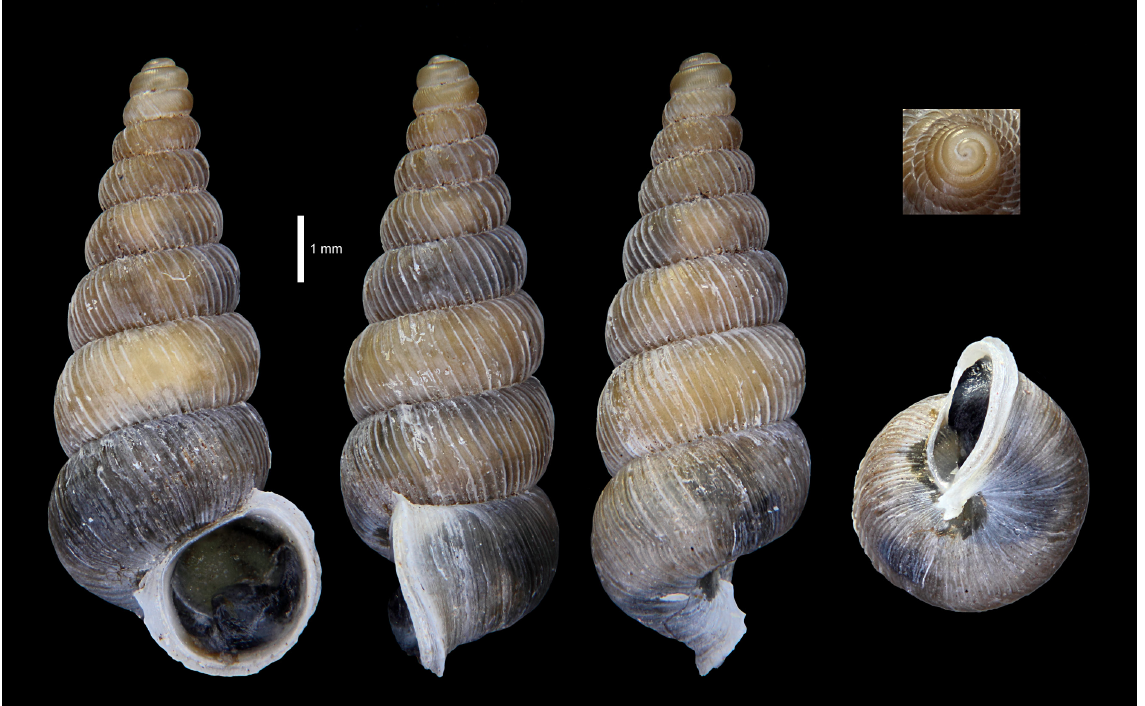
Fig. 10. Cochlostoma (Lovcenia) tropojanum Zallot, Fehér & Gittenberger sp. nov., holotype, Tropojë Valley, Albania (NHMW